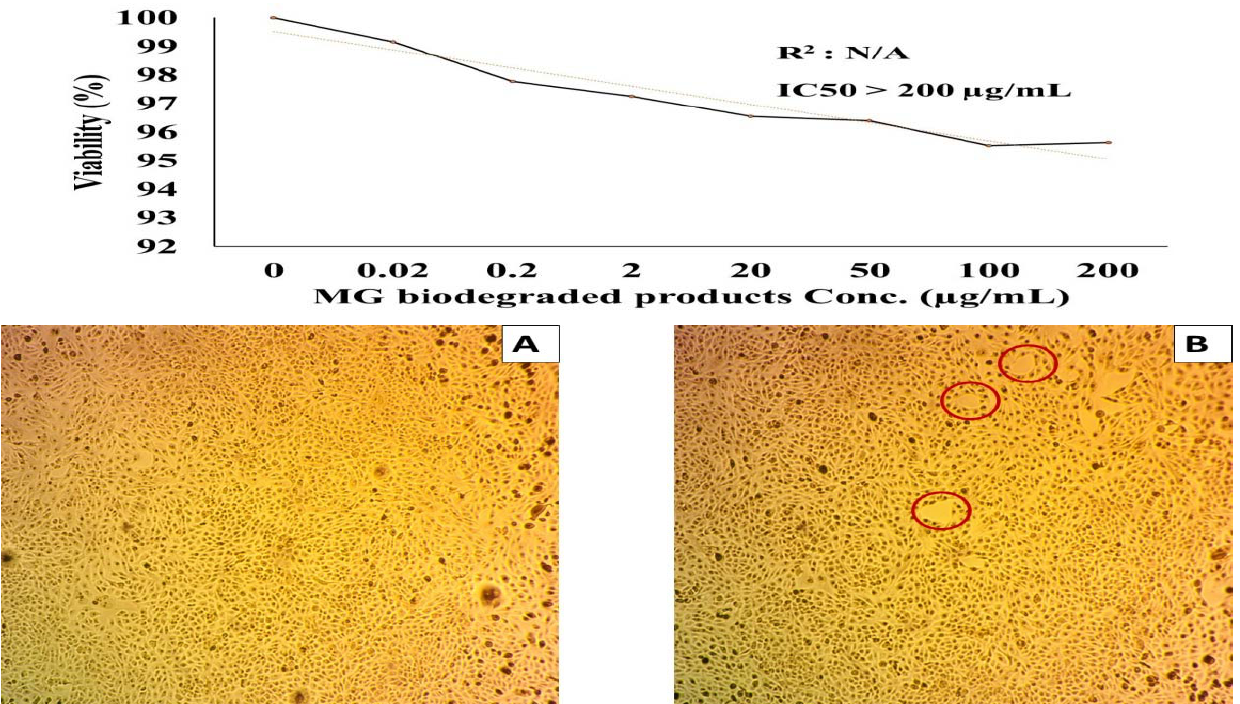
10 of 24 Figure 9. Microbial toxicity of MG biodegraded products against bacterial and fungal strains ( A ) S. aureus ATCC 29737, ( B ) E. coli ATCC 8379, ( C ) C. albicans ATCC 60193, and ( D ) A. niger ATCC 16,404 using the well diffusion method on Muller–Hinton agar indicating no inhibition growth for all strains. 2.6. Cytotoxicity The effects of the biodegraded MG products were studied in normal HSF cells using an MTT assay at ten concentrations from 0 to 200 μ g/mL. As shown in Figure 10, there was no toxicity observed at both the low and high concentrations in normal HSF cells. At the lower concentration of 1 μ g/mL, the HSF cells showed 97% cell viability, compared to 96% at an MG byproduct concentration of 200 μ g/mL. An HSF cell viability of 100% was